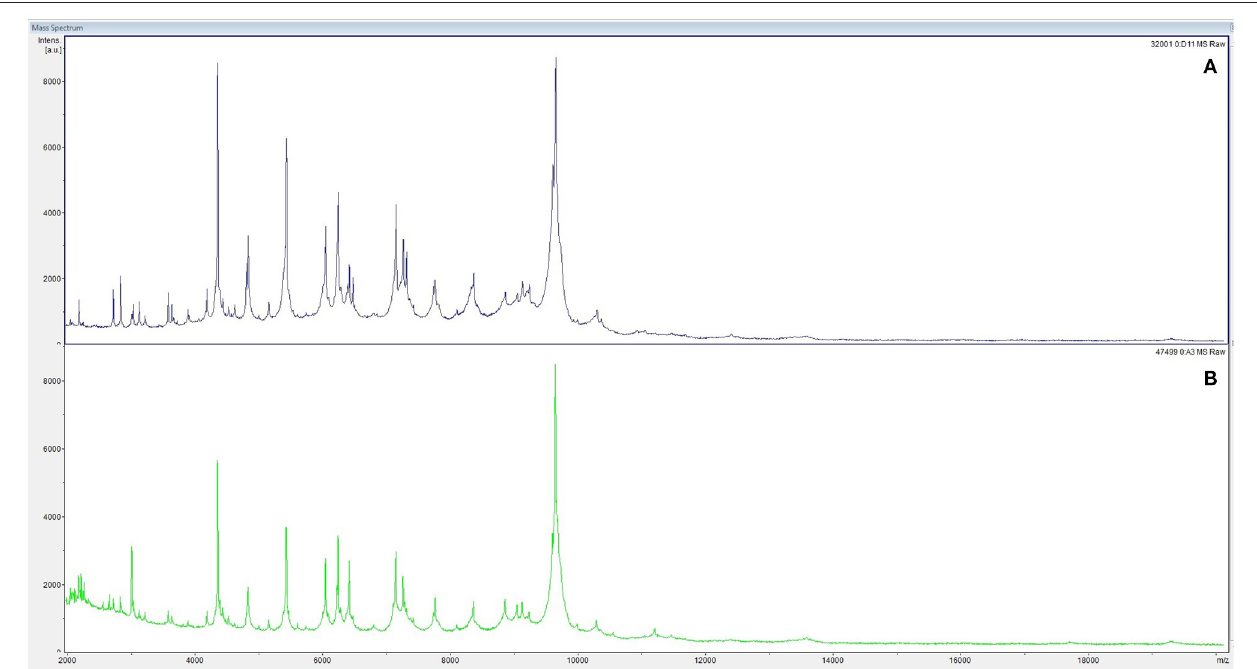
FIGURE 3 | Peptide mass fingerprinting of Y. enterocolitica from peripheral blood cultures (A) and from aneurysm specimens (B) by MALDI-TOF MS.